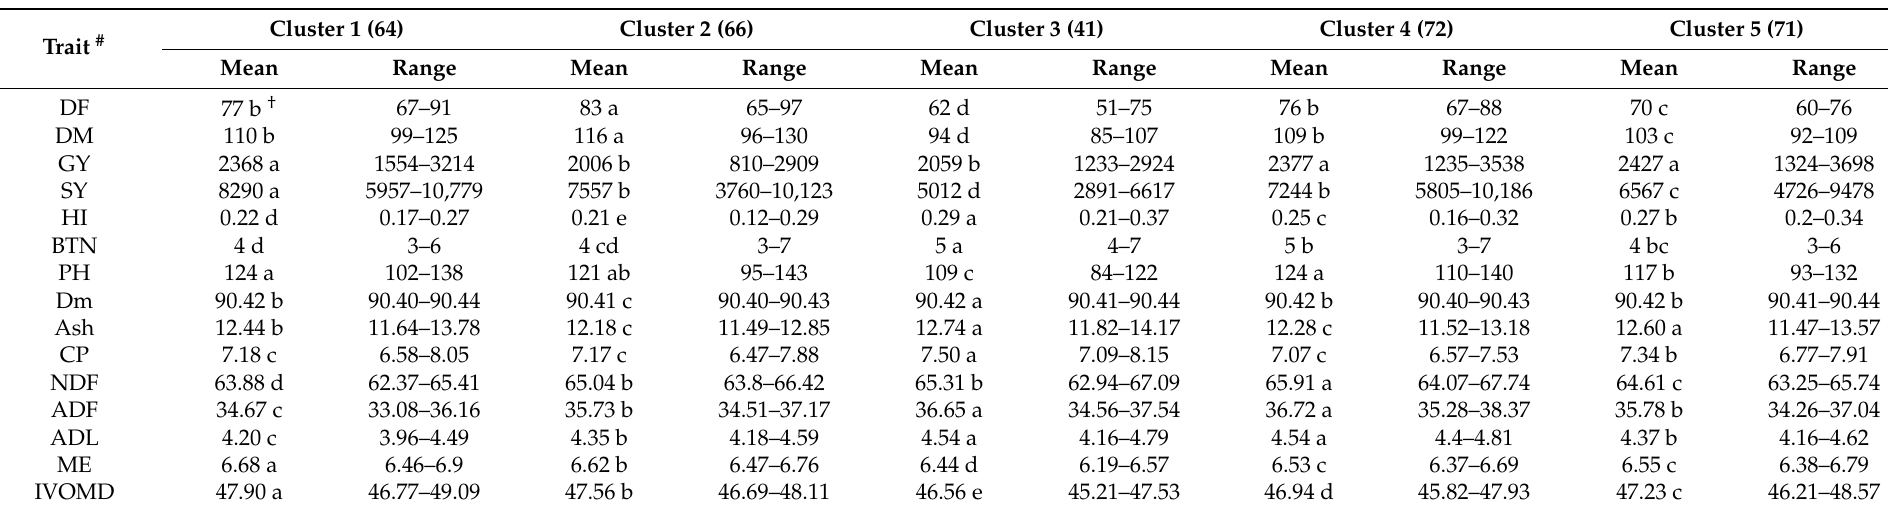
Table 5. Mean comparison among five clusters for agronomic and forage quality traits in 314 finger millet